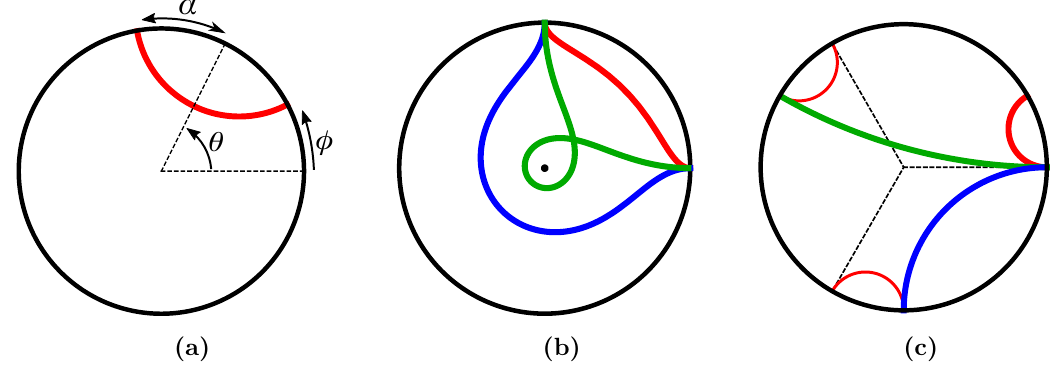
Figure 1 . (a) The Poincare disk showing a geodesic and its kinematic coordinates. (b) A spa- tial slice of a conical defect, with N = 3 for illustration, showing three geodesics subtending the same boundary interval with winding numbers n = 0 ; 1 ; 2 respectively in order of increasing